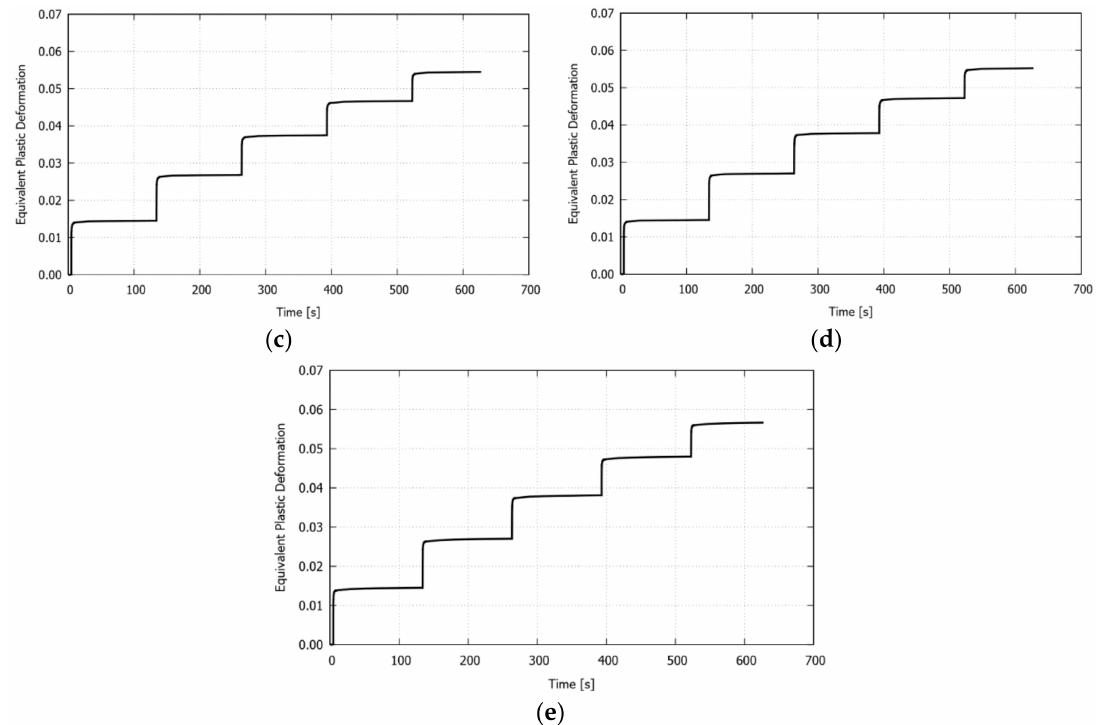
Figure 13. Multiple circular scanning path: computed equivalent plastic deformation evolution at the middle point of the laser path for the studied configurations, ( a ) r inn = 0 mm, ( b ) r inn = 10 mm, ( c ) r inn = 15 mm, ( d ) r inn = 20 mm, and ( e ) r inn = 25